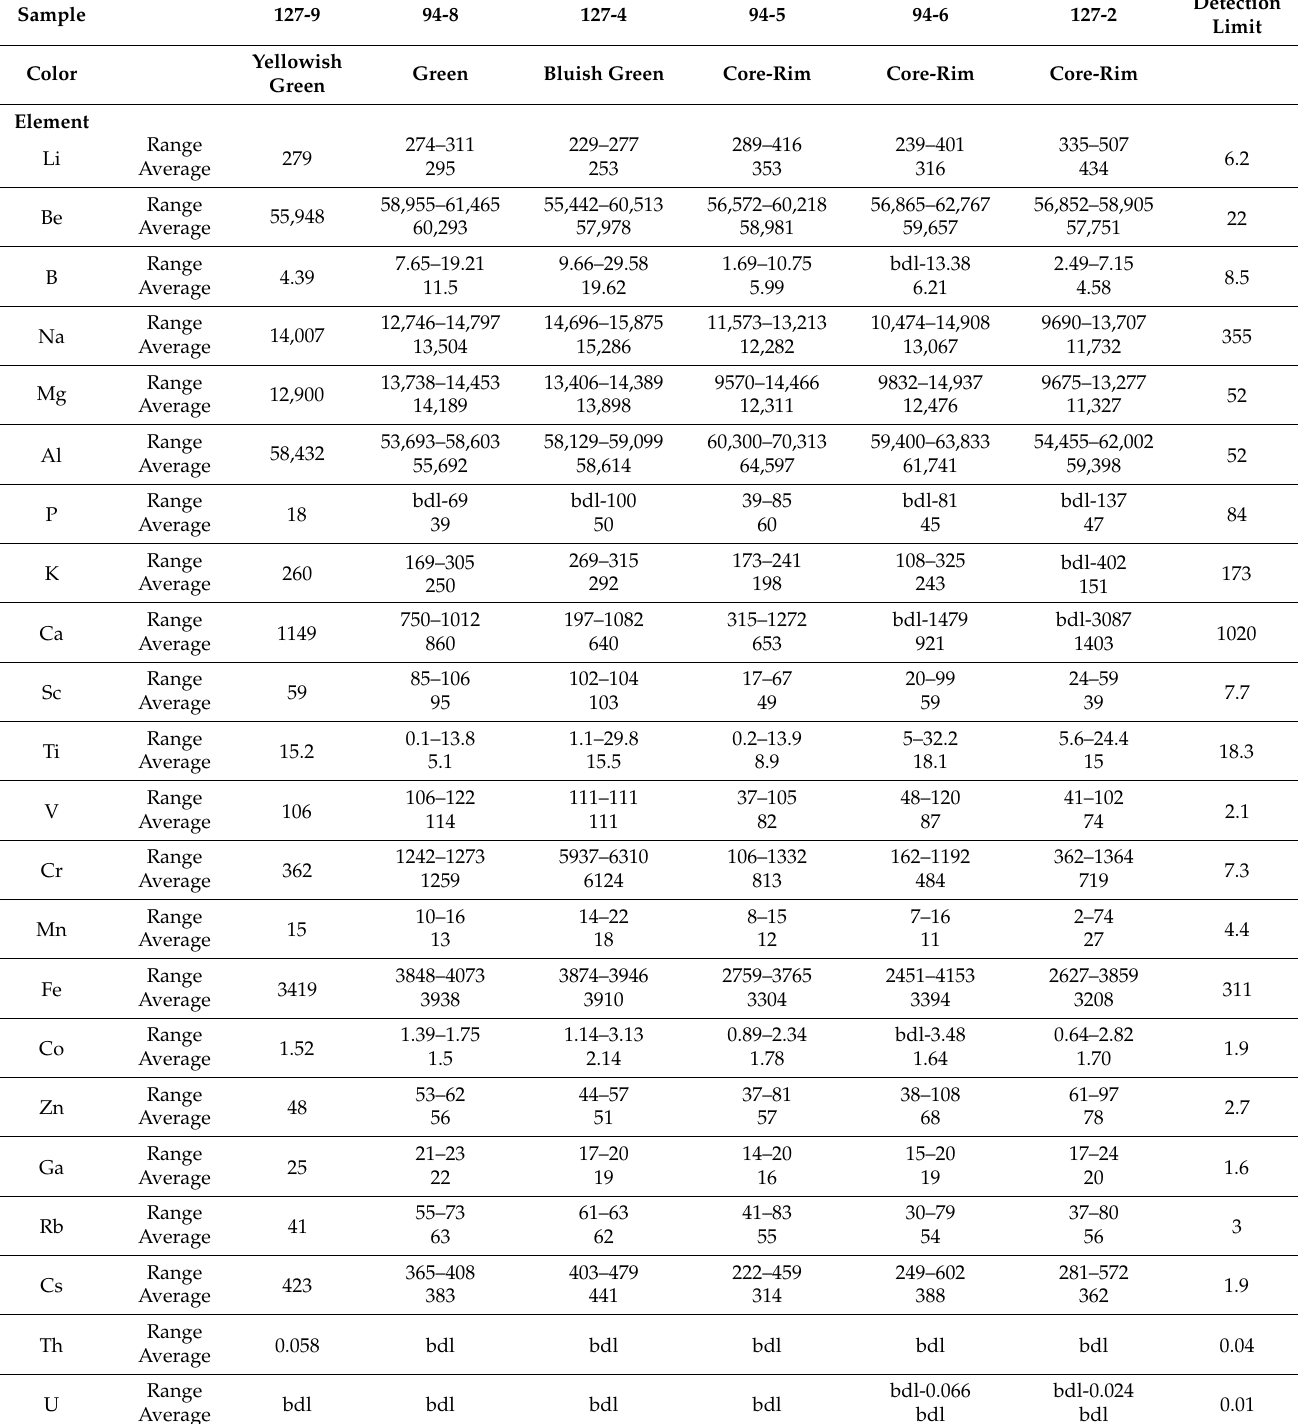
Table 3. Chemical composition (average) of Indian emeralds, obtained by LA-ICP-MS (in